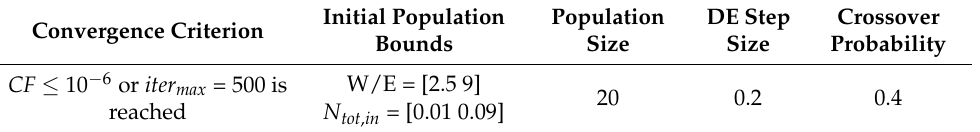
Table 3. Algorithm parameters for Differential Evolution